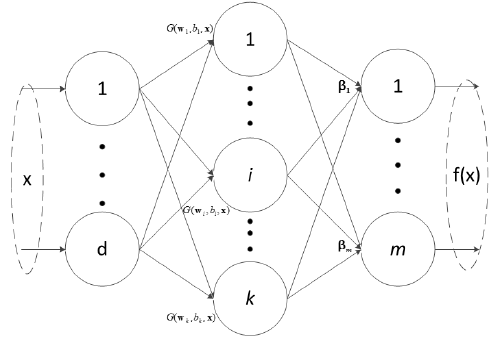
Figure 1. The structure of